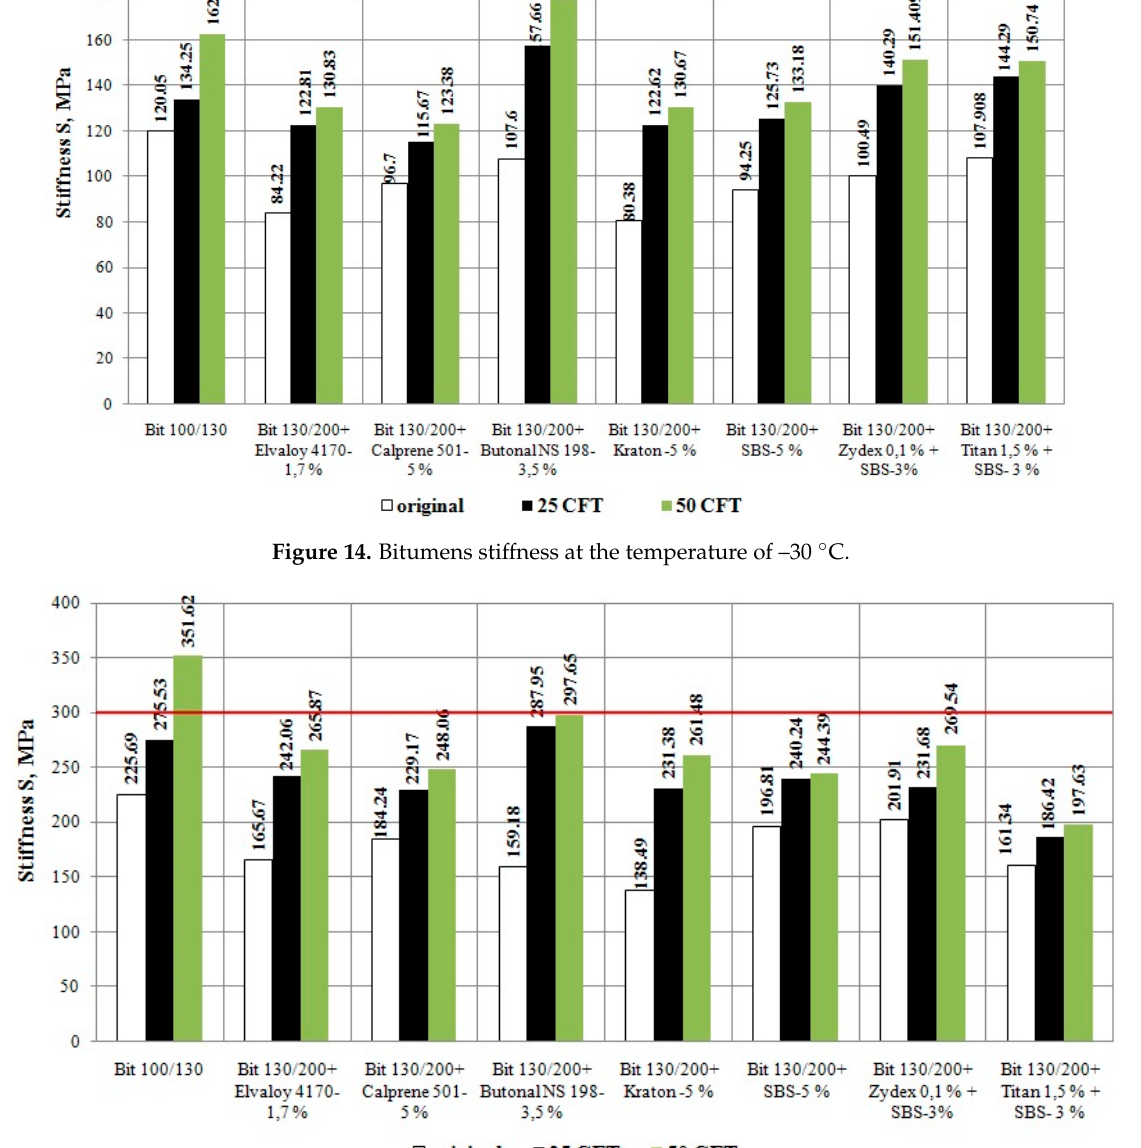
Figure 15. Bitumens stiffness at the temperature of –36° С .